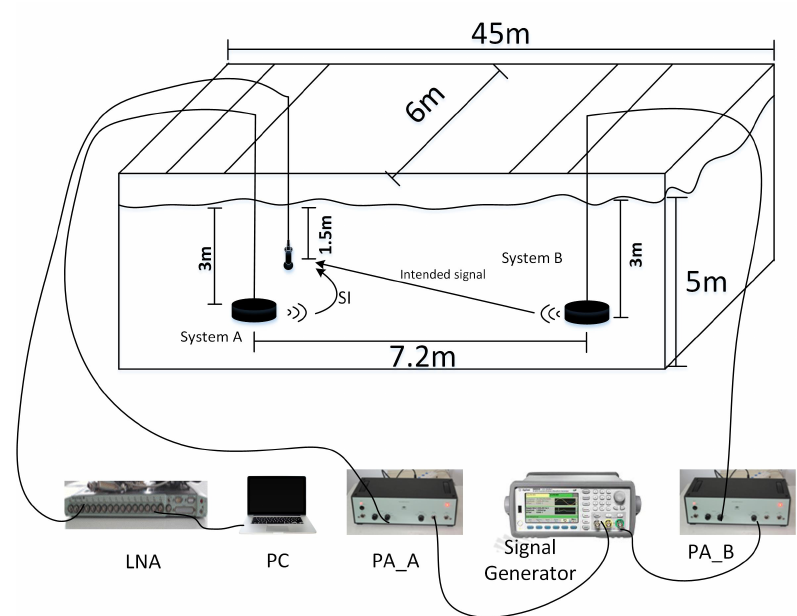
Figure 12. Schematic diagram of a pool experiment.